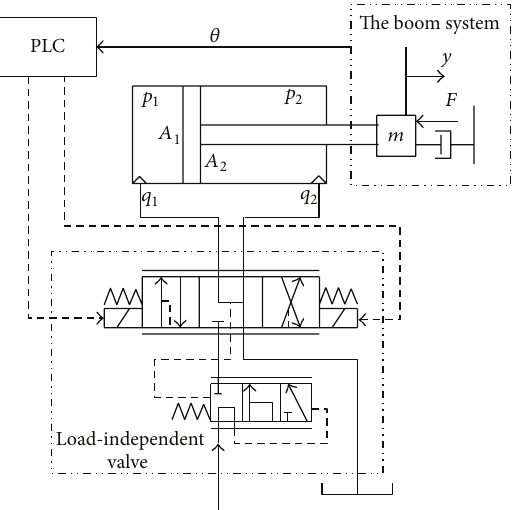
Figure 1: Electrohydraulic control